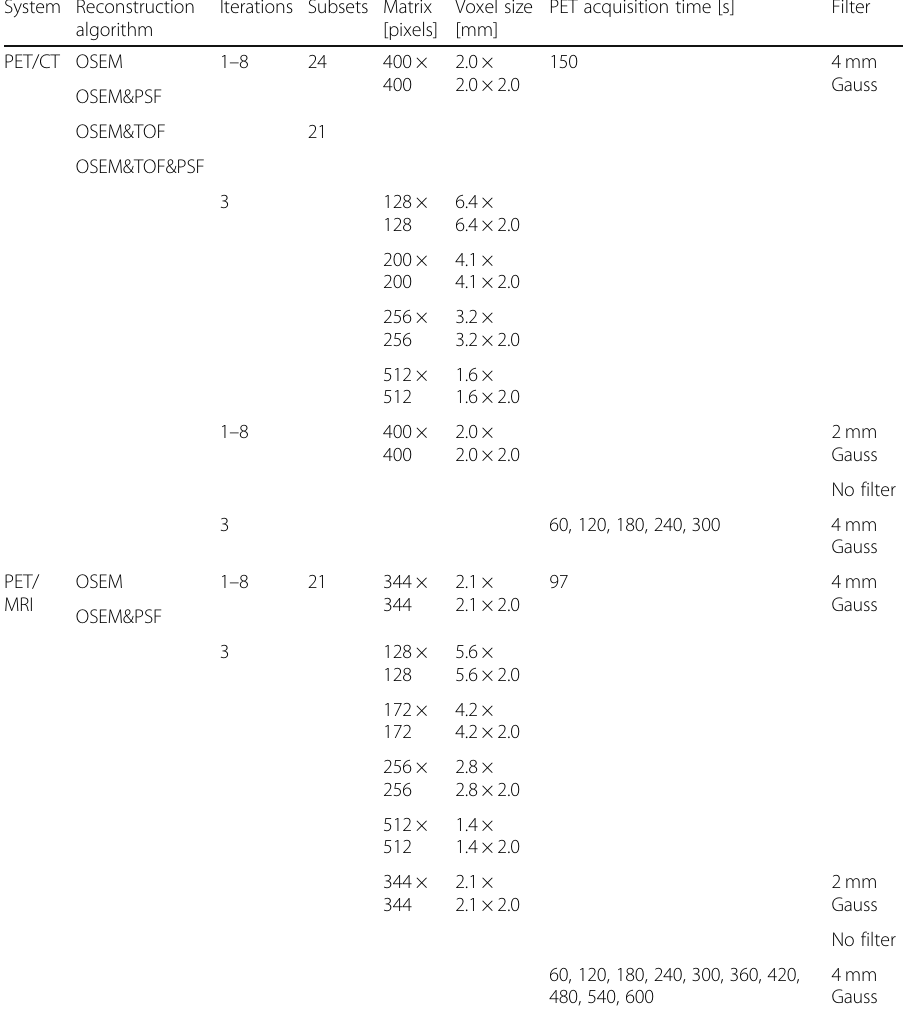
Table 2 Evaluated reconstruction settings for the phantom PET scans for both 8:1 and 4:1 activity concentration System Reconstruction